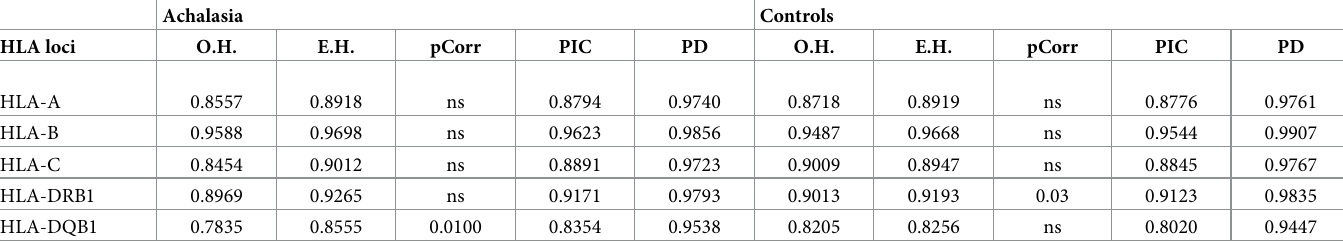
Table 2. Estimations of genetic diversity of HLA class I and class II loci in Mexican admixed individuals with achalasia and controls.